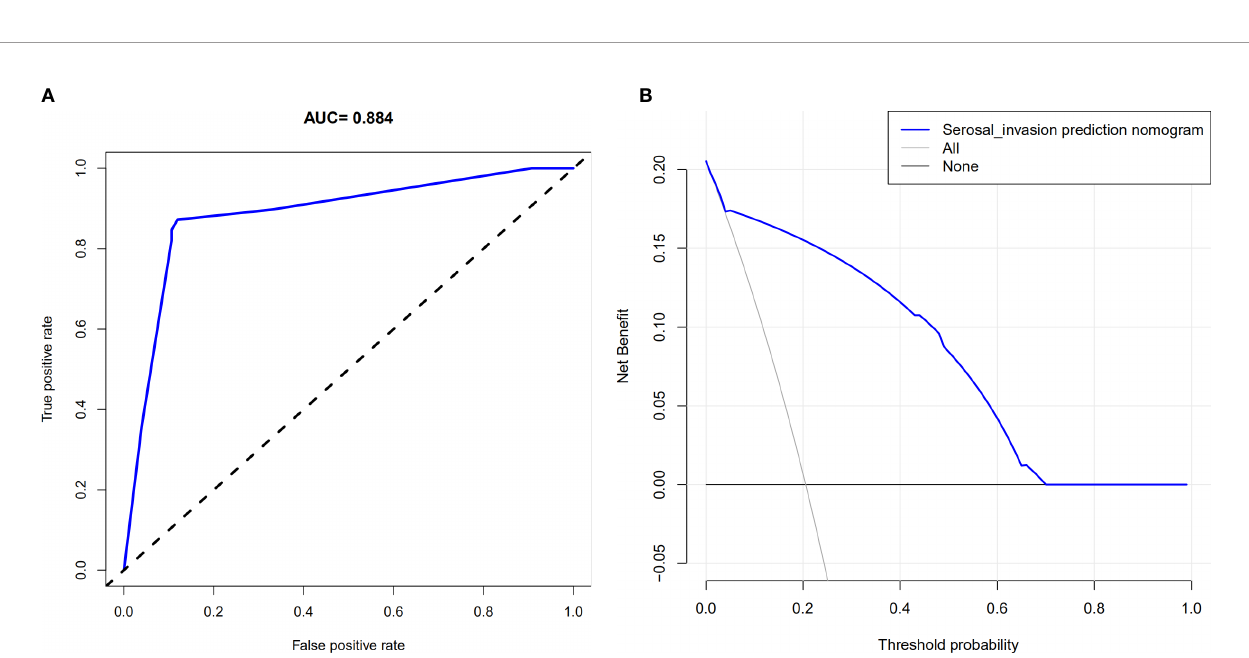
FIGURE 3 | Area under the curve of the prediction model and decision curve analysis for the radiomics nomogram in the training cohort. (A) The area under the curve represents the reliability of the model; the larger the value, the more reliable the model. (B) The y-axis measures net income. The gray line indicates that the patient has serous invasion, and the black line indicates that the patient has no serous invasion. The blue line represents the bene fi t of the patient after using the prediction